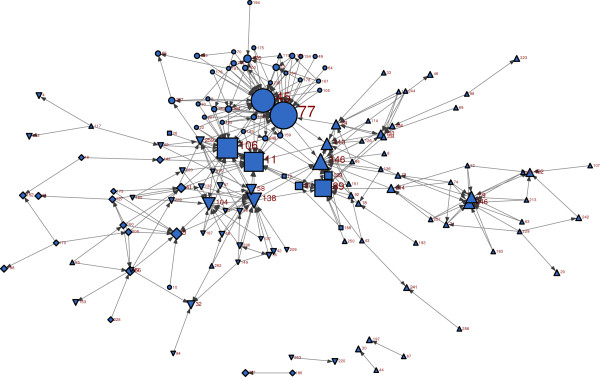
Recognition of expertise (Q3) network. Nodes are sized by their in-degrees.Up-triangle: #1 Diamond: #2Square: office of the Medical Officer of Health Circle: #4Down-triangle: #5.